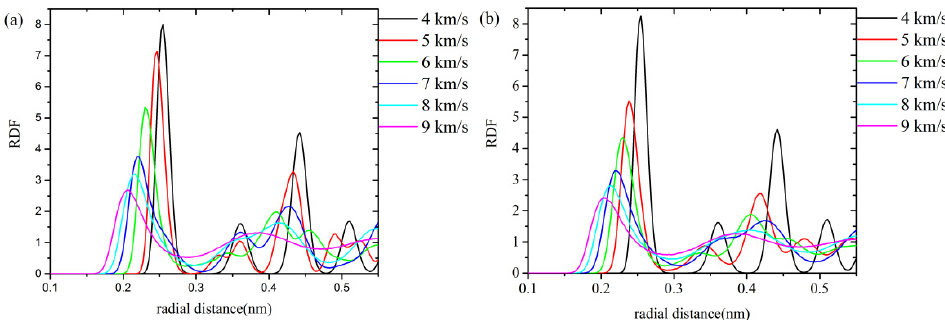
Figure 6. Radial distribution function (RDF) for the copper atom of ( a ) the voids-free system and ( b ) the nanovoid-containing system at different shock wave velocities.